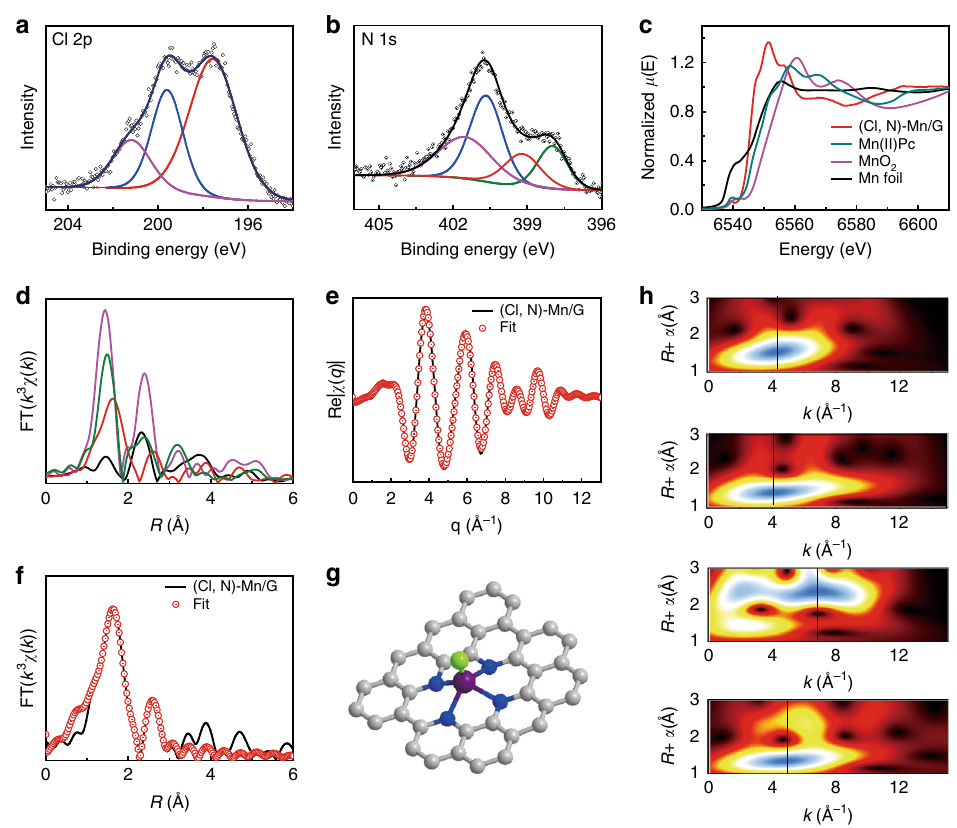
Fig. 2 Fine structure of (Cl, N)-Mn/G. a , b High-resolution Cl 2p and N 1s XPS spectra. c , d XANES and EXAFS spectra at Mn K-edge. ( e ) EXAFS fi tting curves of (Cl, N)-Mn/G in q space. f EXAFS fi tting curves of the (Cl, N)-Mn/G in R space. g Schematic model of (Cl, N)-Mn/G: Mn (purple), Cl (green), N (blue), and C (gray). h WT of (Cl, N)-Mn/G, Mn(II)Pc, Mn foil and MnO 2 (from top to